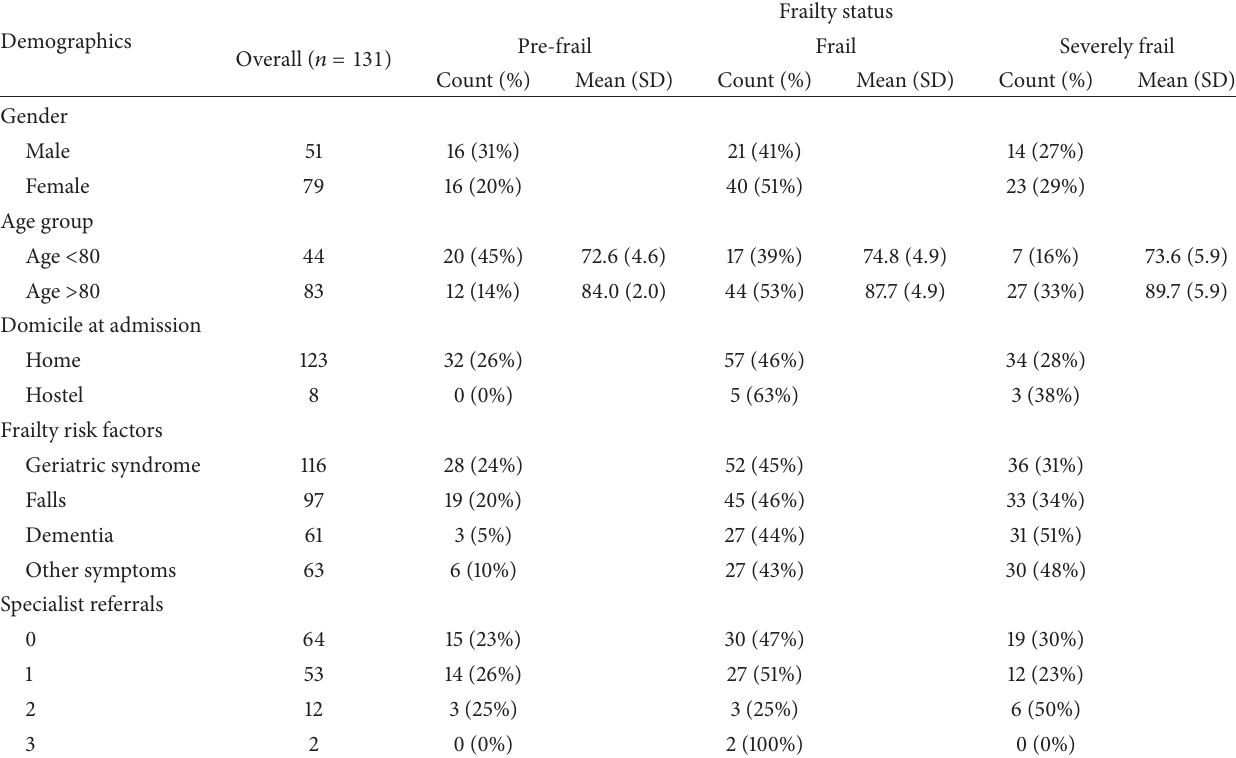
Table 1: Demographics, frailty categories, and the presence of geriatric